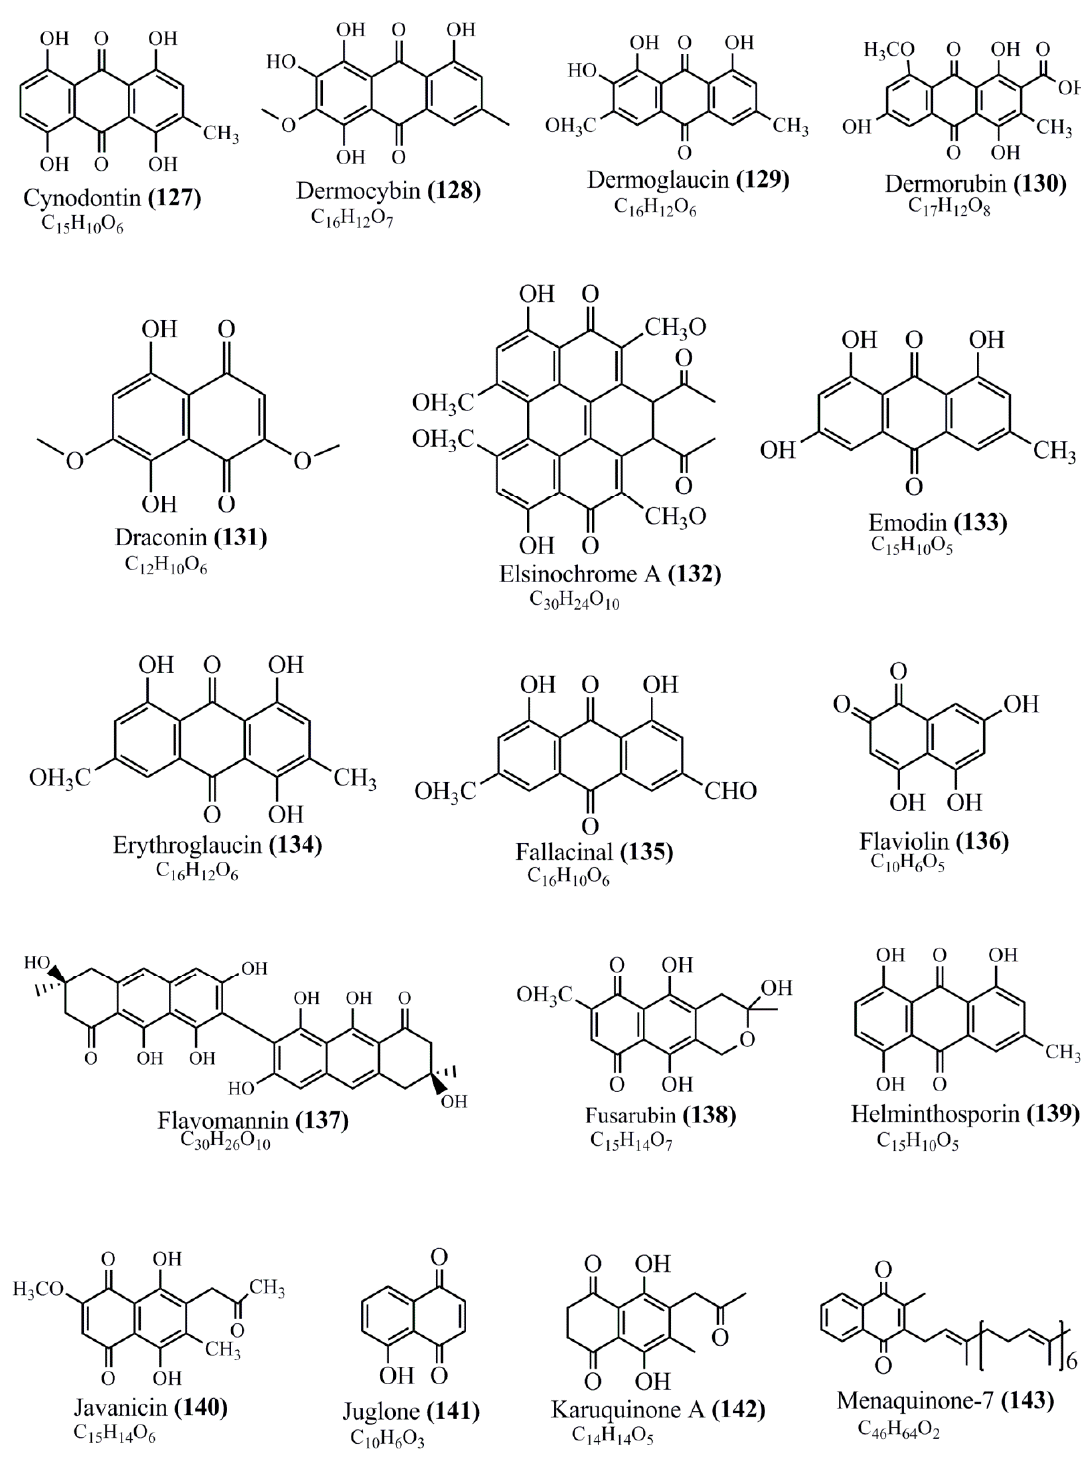
Figure 1. Figure 1. Continued.